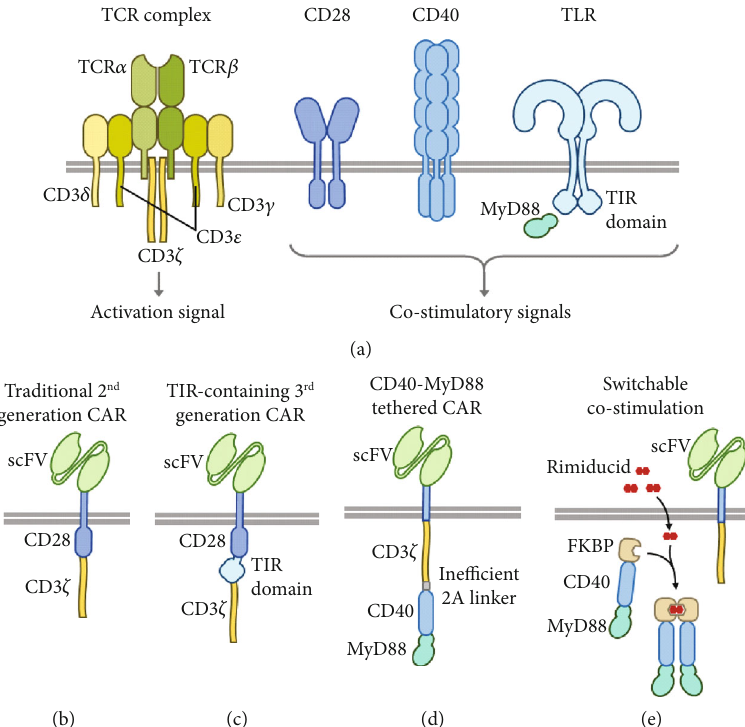
Figure 2: TLR-based strategies for improvement of CAR T cells. (a) Schematic presentation of wild-type T cell proteins from which signaling domains are derived to construct chimeric synthetic receptors. (b) Traditional second-generation CAR containing an scFV domain for antigen recognition on the extracellular portion and CD3 ζ and costimulatory signaling domains on the cytosolic side (CD28 domain is shown here as an example). (c) A third-generation CAR with a TIR signaling domain derived from TLRs. (d) A CD40-MyD88 fusion protein tethered to a fi rst-generation CAR through an ine ffi cient 2A linker. (e) The CD40-MyD88 fusion is linked to a rimiducid-binding domain from an FKBP protein to form a pharmacological switch that can transmit a costimulatory signal by dimerization upon rimiducid